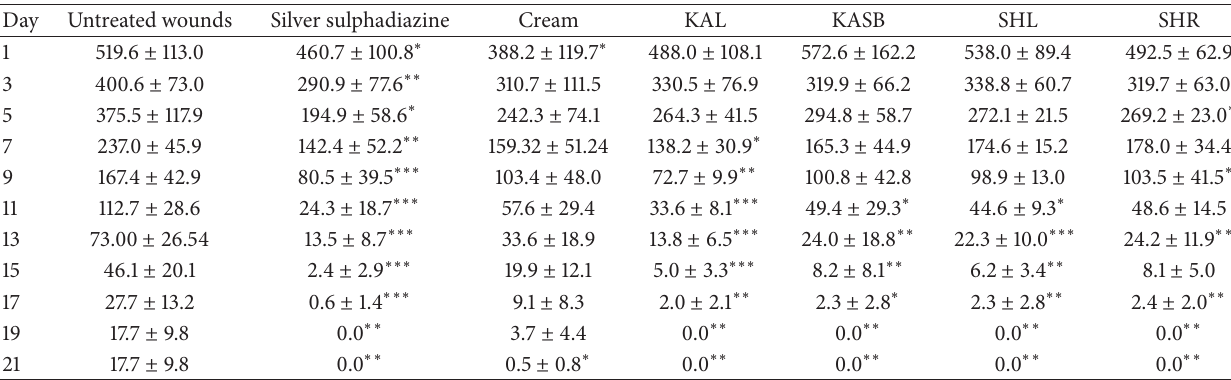
Table 5: Summary of wound closures for selected time points. Values are mean wound area (mm 2 ) ± SEM, for untreated wounds and wounds treated with 1% w/w silver sulphadiazine, 7.5% w/w K. africana extract cream (KAL), and stem bark extract (KASB) of K. africana and leaf extract(SHL),rootextract(SHR)of S. hispidus andcreamonly. 𝑁 = 6 ratspergroup.Dataanalysedbyone-wayANOVAfollowedbyDunnet’s multiple comparison’s test.